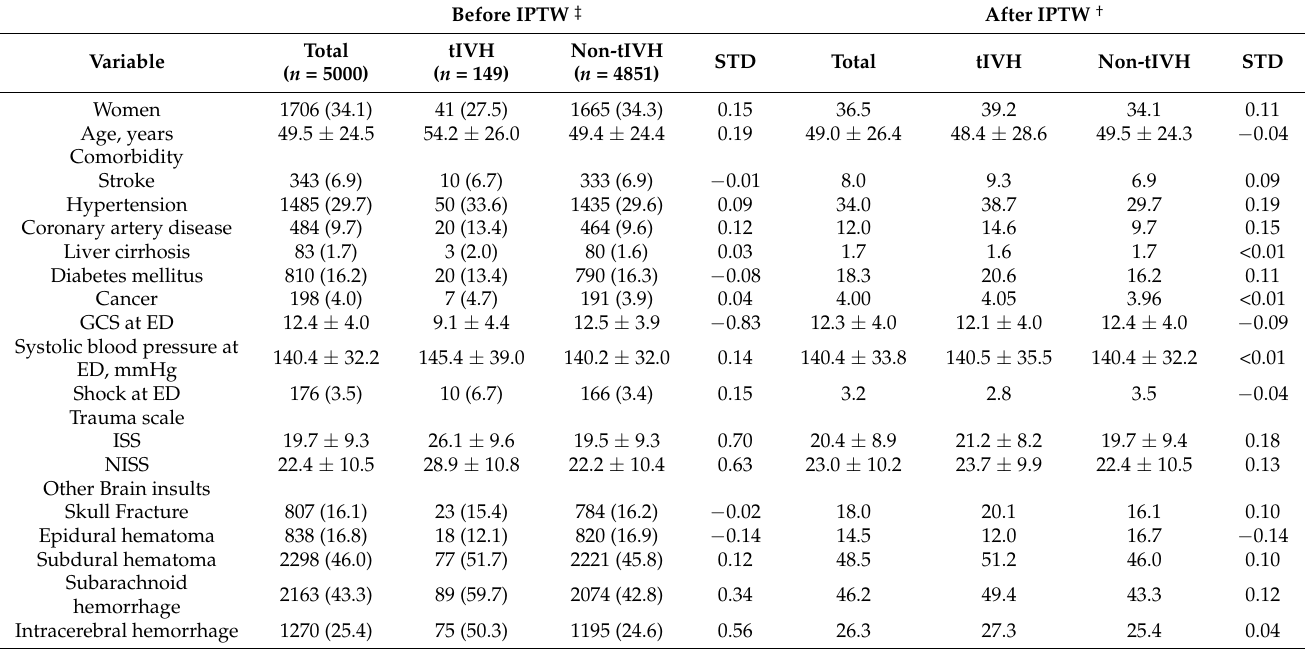
Table 1. Demographics and characteristics of the study participants according to the presence or absence of tIVH ( n =